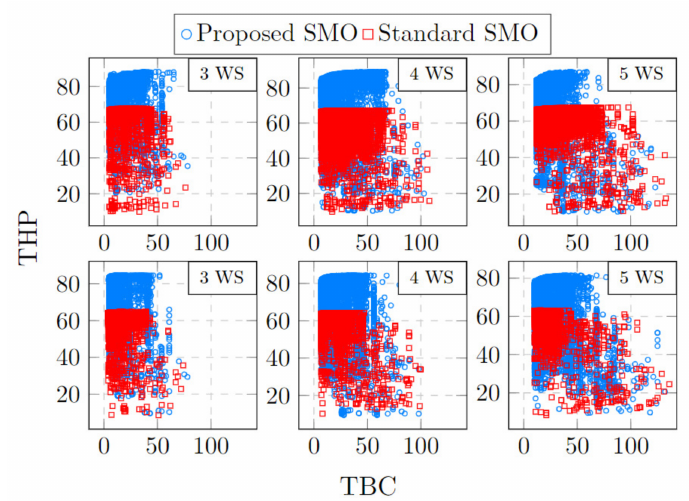
Figure 10. Solution point comparison for the 9 operators scenario distributed in 3, 4, and 5